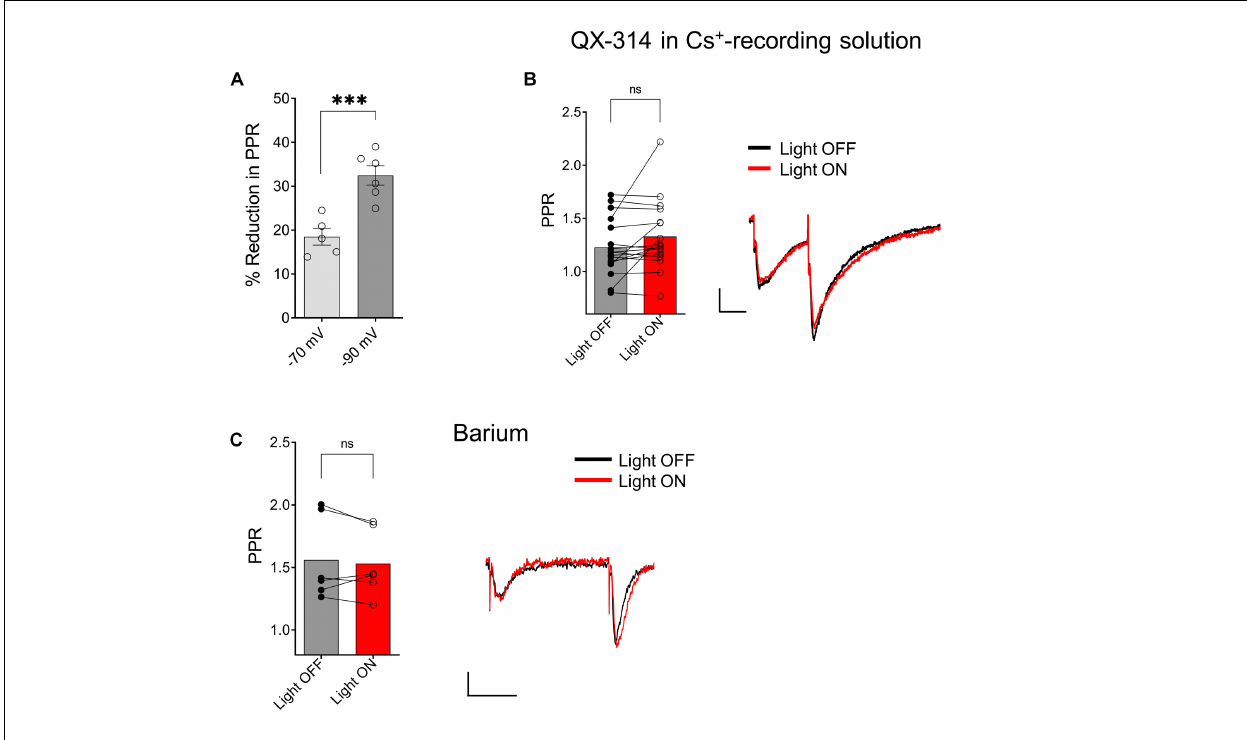
FIGURE 6 | ACh-mediated reduction of SC EPSCs required activation of G-protein coupled inwardly rectifying potassium channels (GIRK). (A) Scatter plot of individual data points overlaid on bar plot demonstrating the ACh mediated reduction in SC EPSCs was larger at more negative holding potentials (unpaired t -test; p = 0.0011). (B) Bar plot (left) and representative EPSCs (right) shows inclusion of QX-314 and cesium in the intracellular recording solution prevented inhibition of SC EPSCs by ACh release (paired t -test; p = 0.0758). (C) Bar plot (left) and representative EPSCs (right) shows extracellular barium prevented inhibition of SC EPSCs by ACh release (Paired t -test; p = 0.4984); Scale bars: x = 25 ms; y = 50